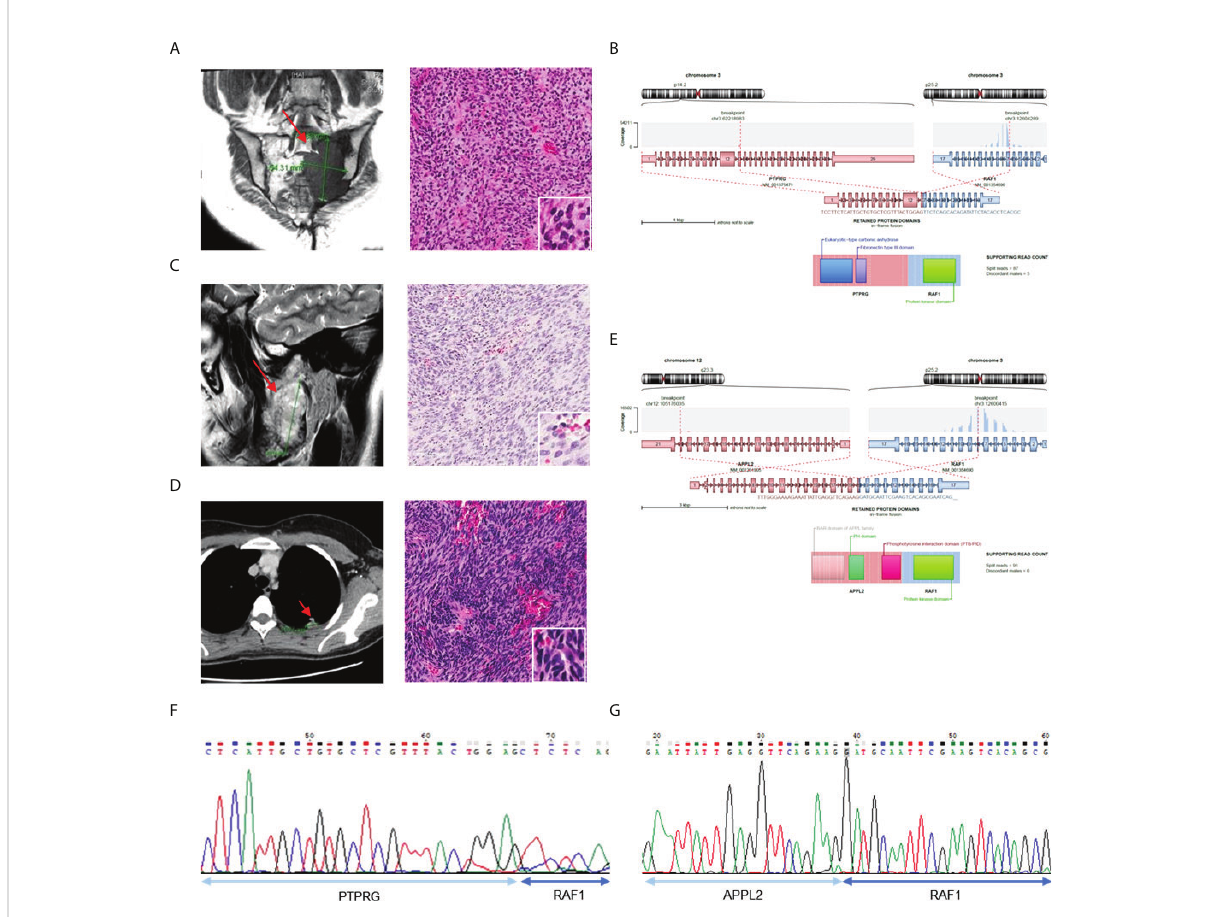
FIGURE 4 Validation of the cases with RAF1 gene fusion. (A) MRI image show tumor in left sacrum (left) and H&E staining of tumor tissue (right). (B) Schematics of PTPRG-RAF1 and remaining protein domains of fusion. (C) MRI of right mandible with 5.3 sized mass (left) and H&E staining with pleomorphic spindle cells with monotonous morphology (right). (D) CT of chest shows metastatic tumor in left upper lobe (left) and H&E staining of tumor tissue (right). (E) Schematics of APPL2-RAF1 and remaining protein domains of fusion. (F) Con fi rmation of PRPRG-RAF1 expression using RT-PCR. (G) Con fi rmation of APPL2-RAF1 expression using